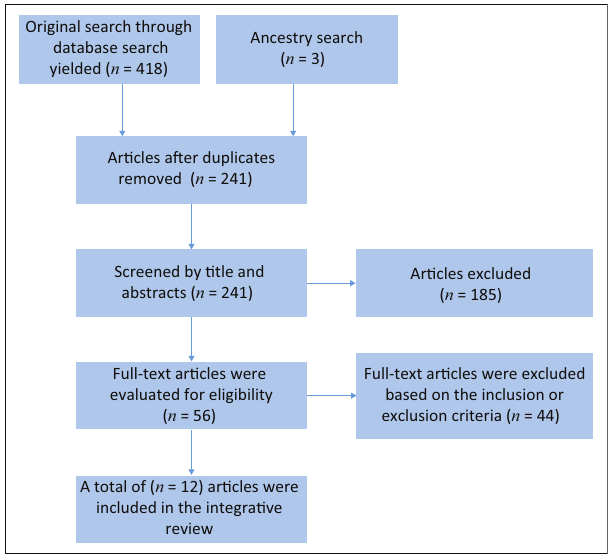
FIGURE 1: Flow chart of search